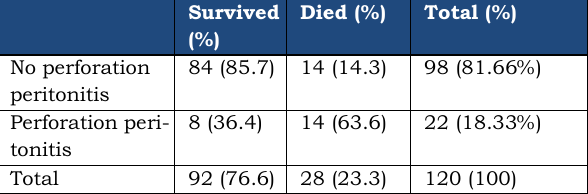
Table 5: Outcome of patients vis-à-vis complication of perfora- tion peritonitis